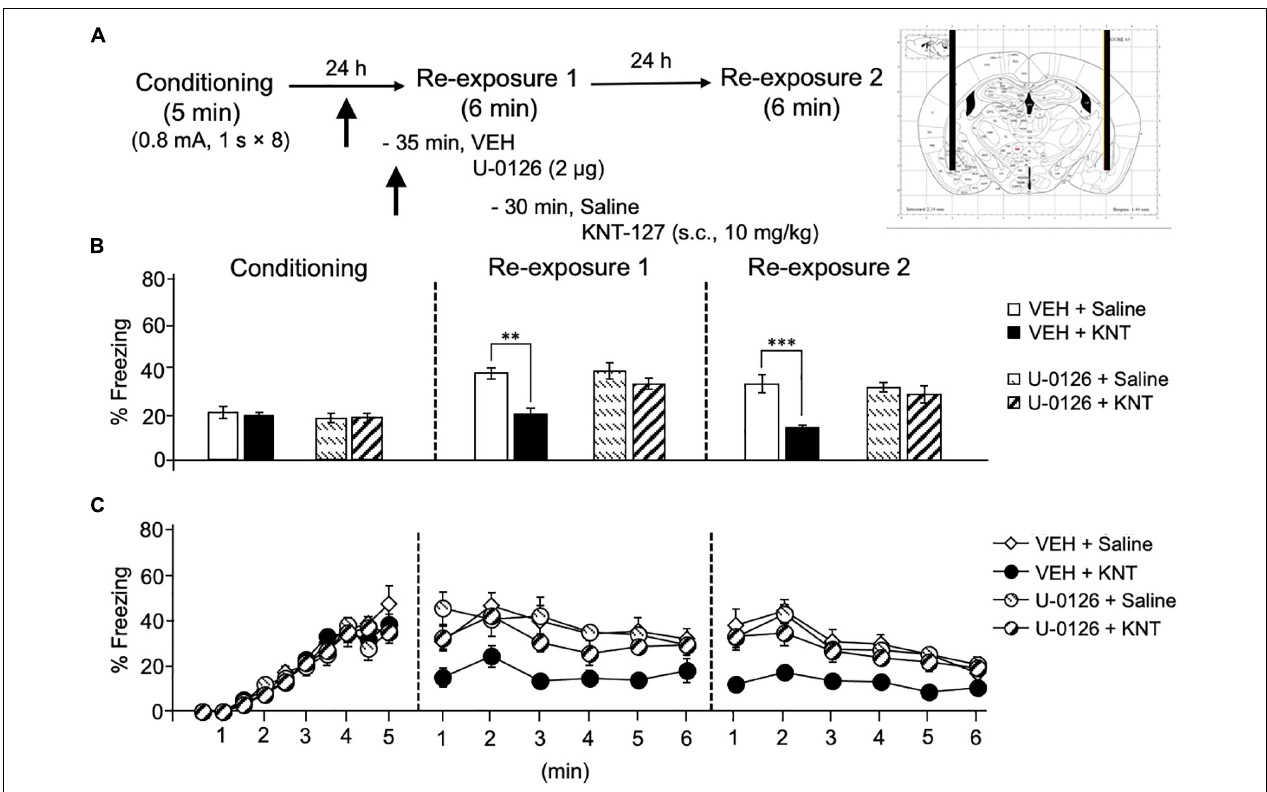
FIGURE 3 | Intra-BLA administration of the MEK/ERK inhibitor blocked the fear-reducing effect of KNT-127. (A) Experimental design. Mice were subcutaneously administered with saline or KNT-127 (10 mg/kg) 30 min before reexposure 1 (6 min). Five minutes before injecting these drugs, a vehicle or a MEK inhibitor, U-0126, was administered bilaterally into the BLA (35 min before reexposure 1). Twenty-four hours after reexposure 1, a fear memory was tested in the same context for 6 min (reexposure 2). (B) Freezing rates of mice during conditioning, reexposures 1 and 2. U-0126 abolished the effects of KNT-127 during reexposures 1 and 2. The number of mice in each group was as follows: n = 6 for vehicle and subsequent saline (VEH + saline), n = 7 for vehicle and subsequent KNT-127 (VEH + KNT), n = 7 for U-0126 and subsequent saline (U-0126 + saline), and n = 7 for U-0126 and subsequent KNT-127 (U-0126 + KNT). (C) Time course of the freezing rates of mice during conditioning, reexposures 1 and 2. Data are expressed as the means ± SEM. Data were expressed as mean ± SEM. ∗∗ p < 0.01, ∗∗∗ p < 0.001 for comparisons between KNT-127 and U-126 treatment groups, by two-way ANOVA and post hoc Bonferroni’s